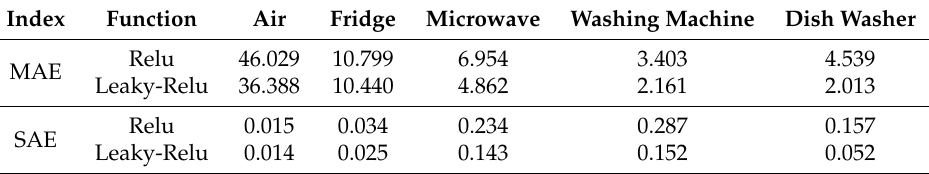
Table 3. Comparison of activation function of Household 25 of the WikiEnergy